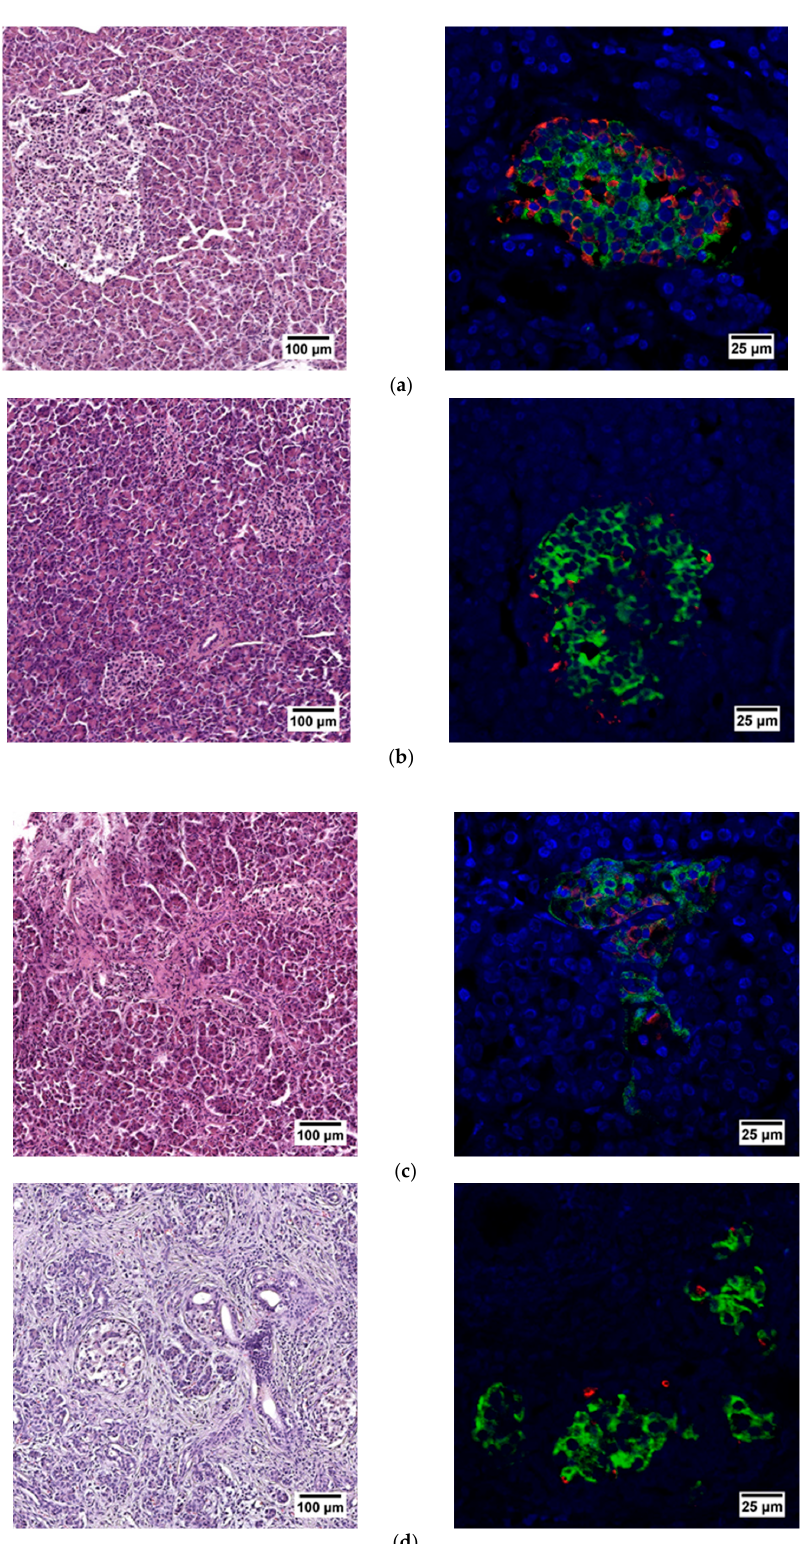
Figure 8. Histological (left) and immunohistochemical (right) analysis of the human pancreas. ( a ) nonpathological patient; ( b ) patient with PDAC; ( c ) patient with chronic pancreatitis + T2D and ( d ) patient with chronic pancreatitis.